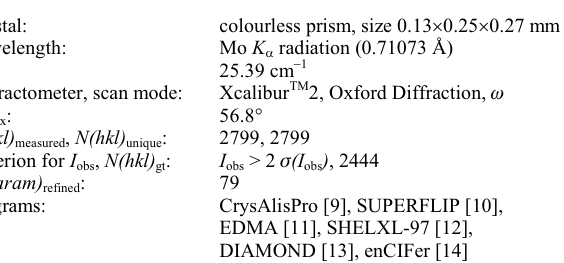
Table 1. Data collection and